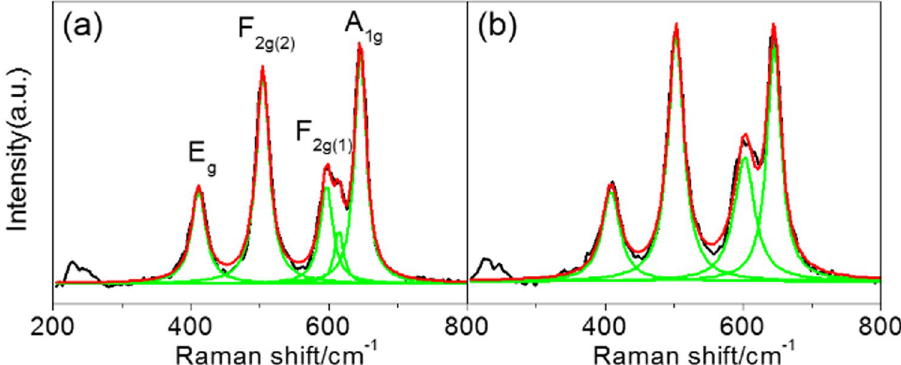
Figure 3. Deconvolution Raman spectra of ( a ) bare − 700 °C sample ( b ) Li-doped − 700 °C